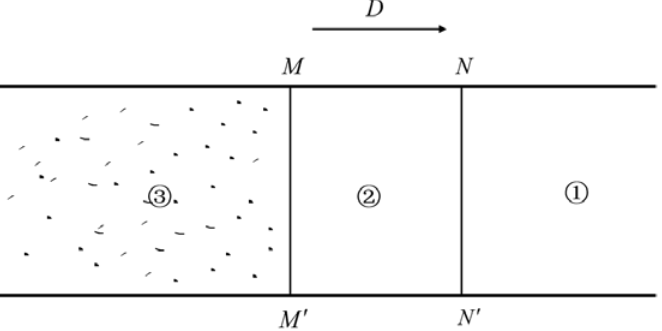
Figure 2. Diagram of detonation wave front [23]. 1 (cid:13) Primary explosive, leading shock wave of cross- section N − N (cid:48) 2 (cid:13) Chemical reaction zone, reaction ends in the cross-section M − M (cid:48) 3 (cid:13) terminates product of the detonation.